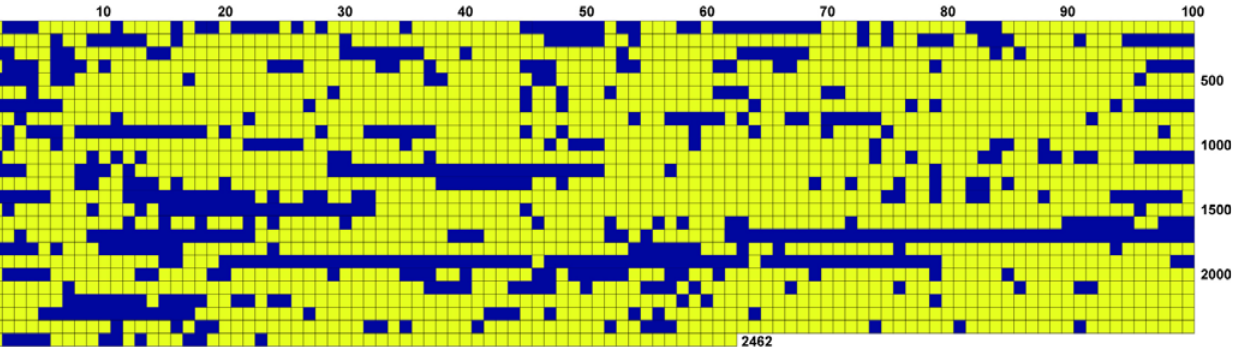
Figure 4. Whole genome display of FNP illustrating clustering of genes without hits in FNN or FNV. Yellow boxes represent FNP genes with either FNN or FNV as top BLASTN hits (1835/2462 or 75%) and blue boxes represent genes whose top BLASTN hits are to genes from other organisms (627/ 2462 or 25%).